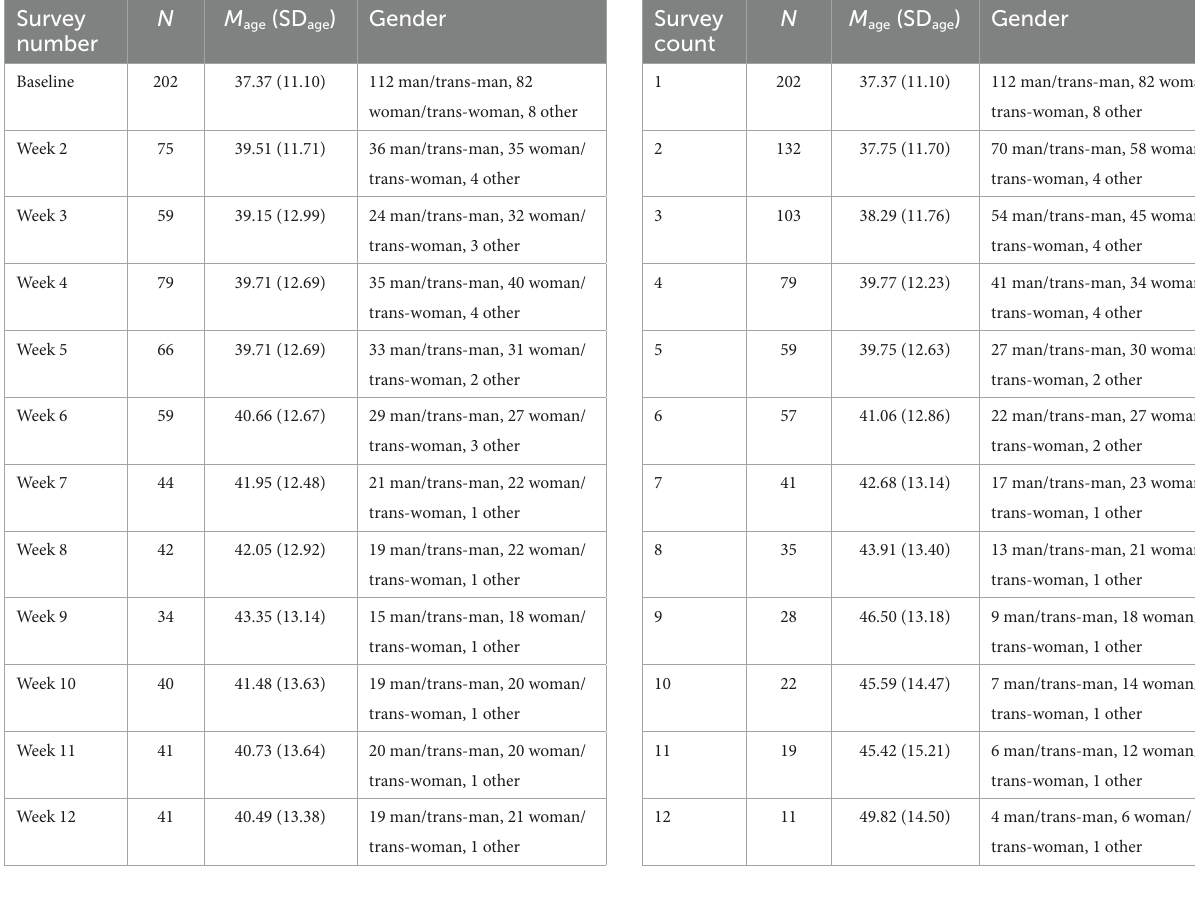
TABLE 1A Demographic data for participants who completed each week of surveys.